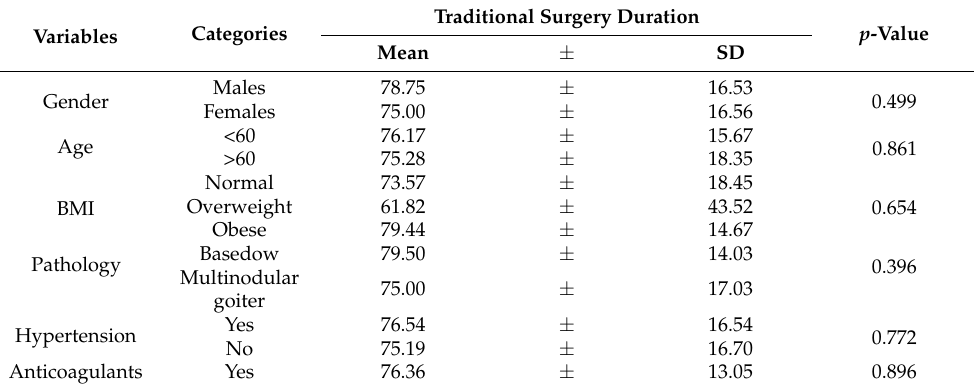
Table 6. Analysing variables influencing Surgery duration for Traditional group. Abbreviation: BMI: Body Mass Index.